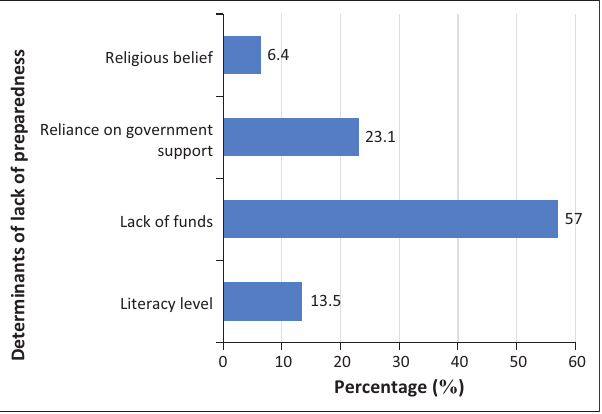
FIGURE 9: Percentage of respondents’ adaptive coping mechanisms.